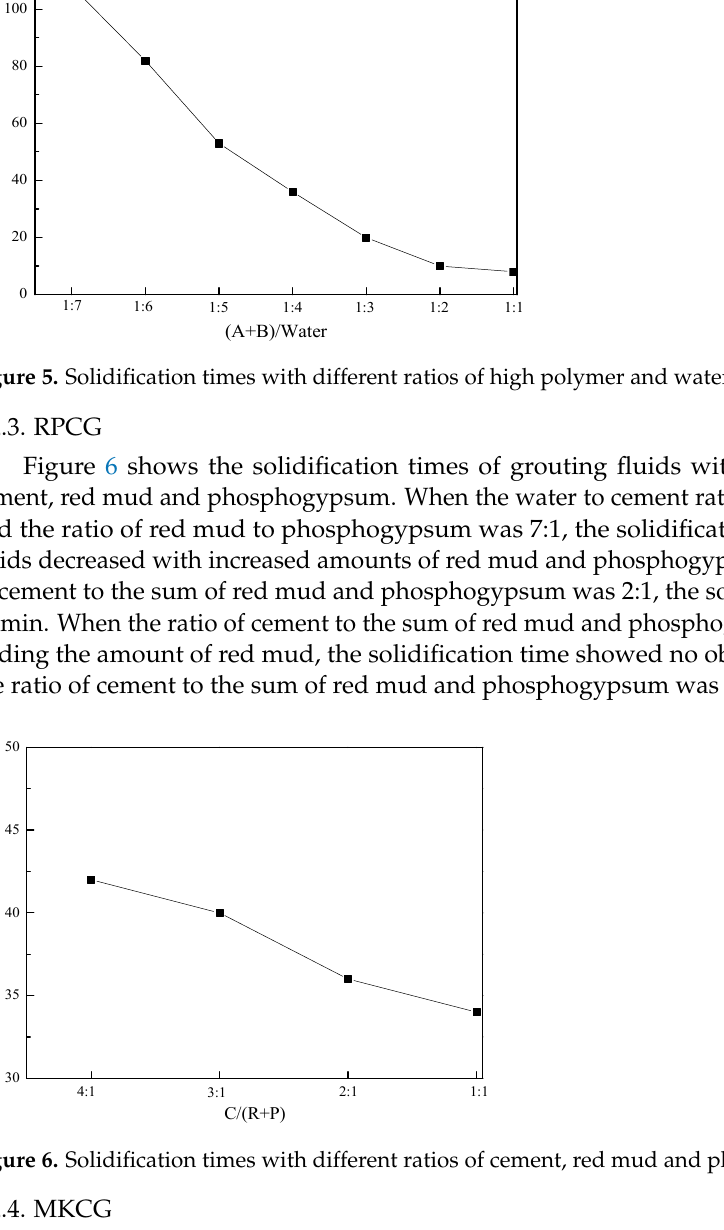
Figure 4. Solidification times with different ratios of group A and group B.